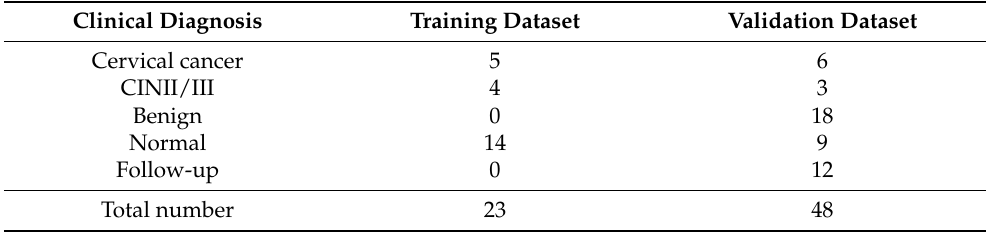
Table 1. Distribution of the 71 participants in the training dataset and the validation dataset based on their clinical diagnosis.